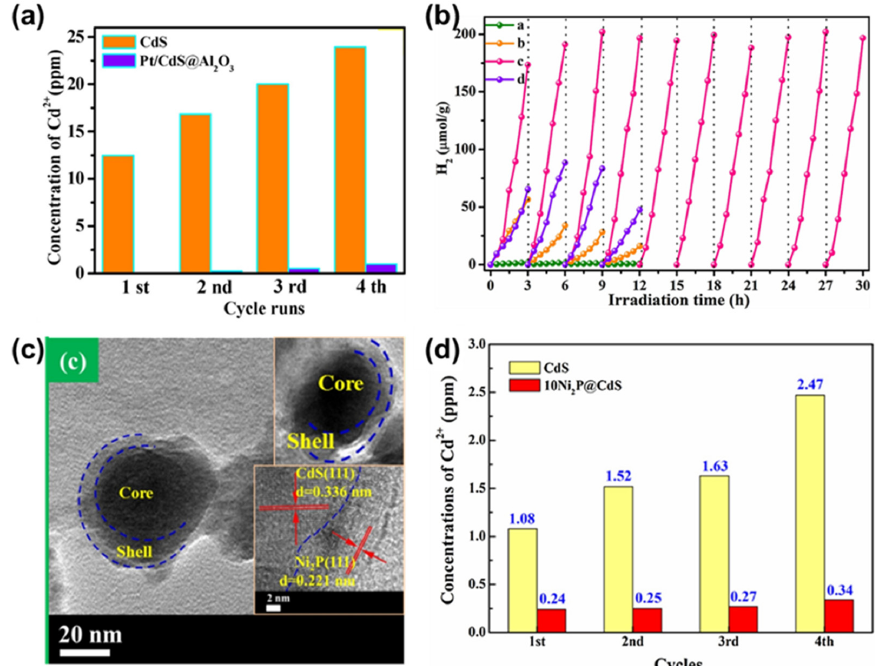
Figure 9. ( a ) The cadmium ion concentration changes in the solution of CdS NPs and Pt/CdS@Al 2 O 3 composite with light irradiation time ( b ) Cycling runs for the photocatalytic hydrogen evolution activity under visible light over various samples: ( a ) CdS NPs, ( b ) Pt/CdS, ( c ) Pt/CdS@Al 2 O 3 with artificial gill and ( d ) Pt/CdS@Al 2 O 3 without artificial gill. ( a , b ) Reproduced with permission from Ref. [112]. Copyright 2018, Elsevier. ( c ) HRTEM images of 10Ni 2 P@CdS and 1Pt@CdS. ( d ) The concentration of Cd 2+ for each run in the reaction solution of CdS and 10Ni 2 P@CdS under visible light irradiation. ( c , d ) Reproduced with permission from Ref. [62]. Copyright 2018, Elsevier.